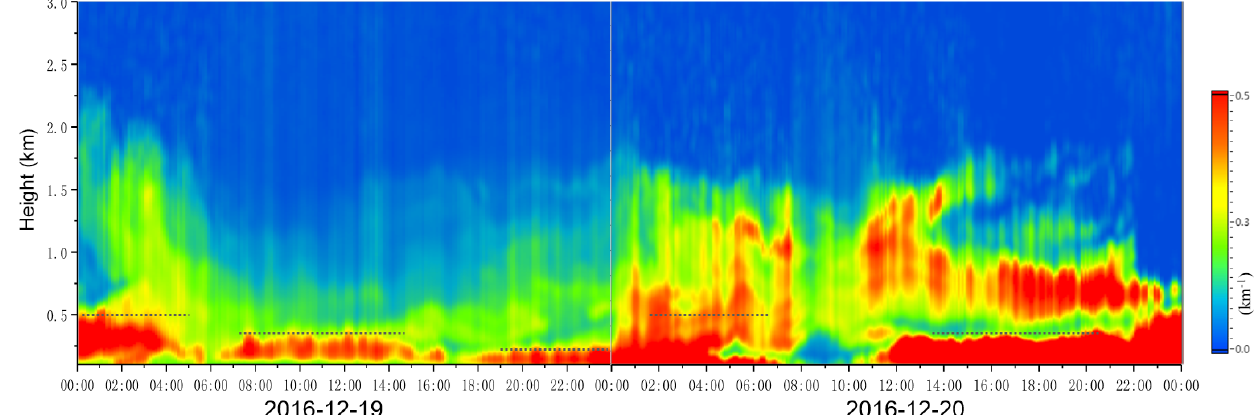
Figure 5. Time series of vertical distributions of the extinction coefficient of aerosols observed in the northern urban area of Beijing from 19 to 20 December 2016. Dashed lines: the approximate boundary-layer